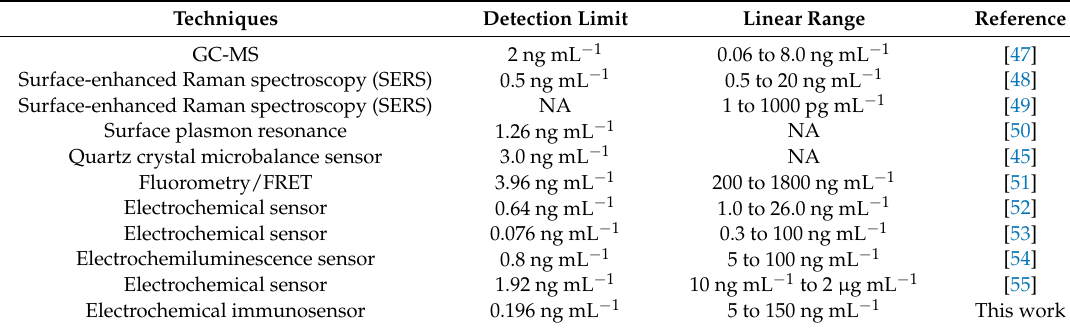
Table 1. Comparison of the analytical performances of developed immunosensor with previous reports method for determination of CLB.